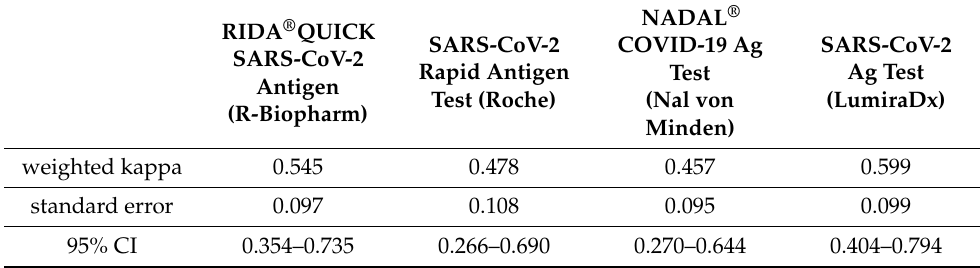
Table 3. Sensitivity and specificity of the examined SARS-CoV-2 Ag-RDTs. (1) Sensitivity % (cell Table 4. Cohen’s weighted kappa coefficient between the Ag-RDTs and the cell culture culture-positive samples), (2) specificity % (cell culture-negative samples).